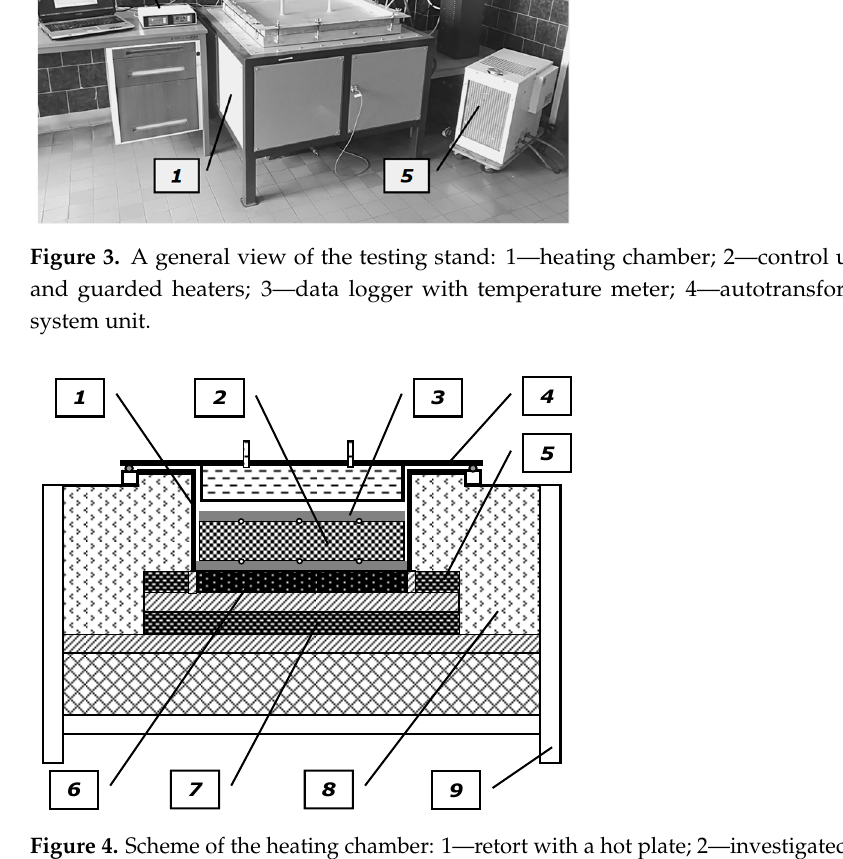
dimensions for the base of 400 × 400 mm and a height of 200 mm, made of a 4 mm boilerplate. From the top, the retort end has a flange with a cover fixed with bolts. There is a main heater under the retort bottom, with the same transverse dimensions of 400 × 400